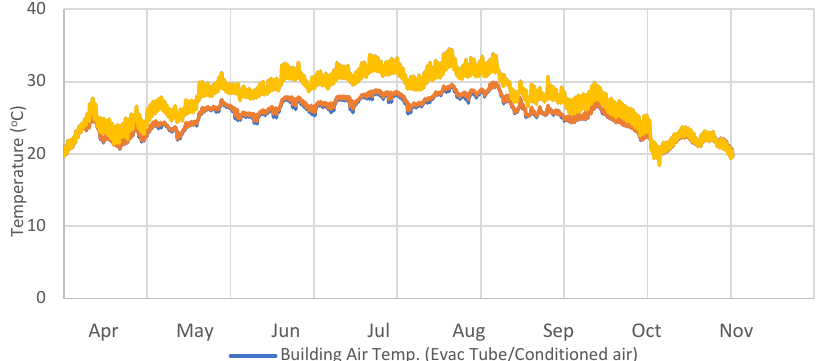
Figure 9. Temperature inside the building for both types of systems using either the evacuated tube or air heating solar collector.